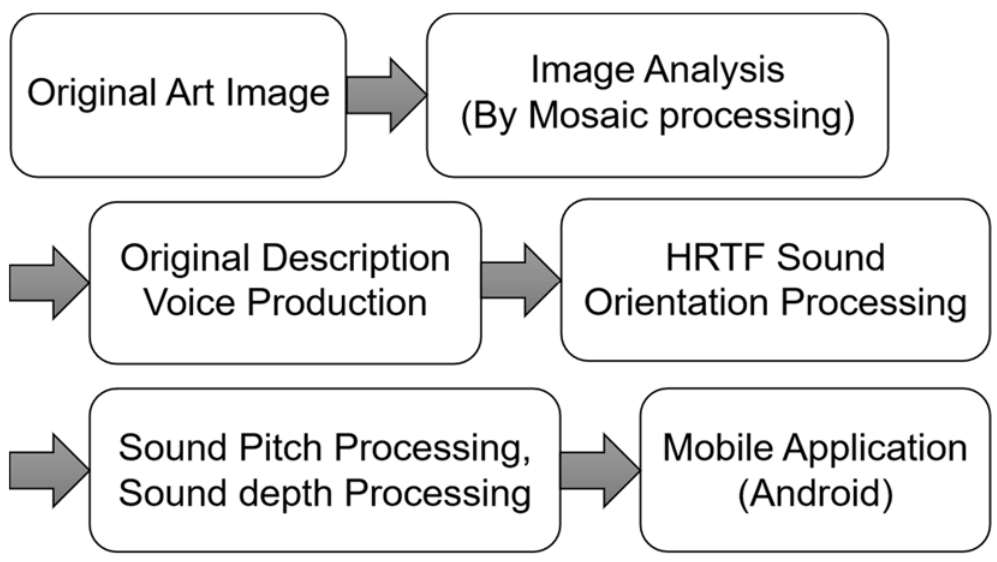
Figure 5. Prototyping process.